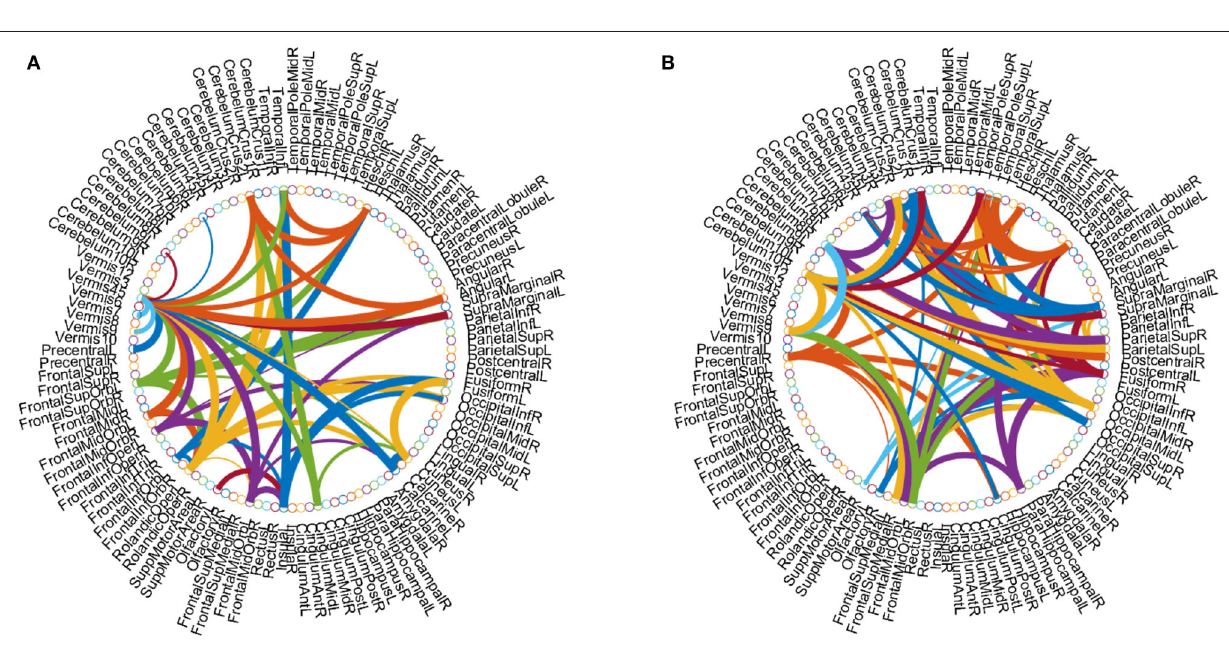
FIGURE 6 | Discriminative functional connectivities for (A) eMCI vs. NC and (B) AD vs. NC classification. Each arc shows the selected connectivity between two ROIs, where colors are randomly allocated for better visualization and the thickness of each arc indicates its discriminative power that is inversely proportional to the corresponding p -value in the t